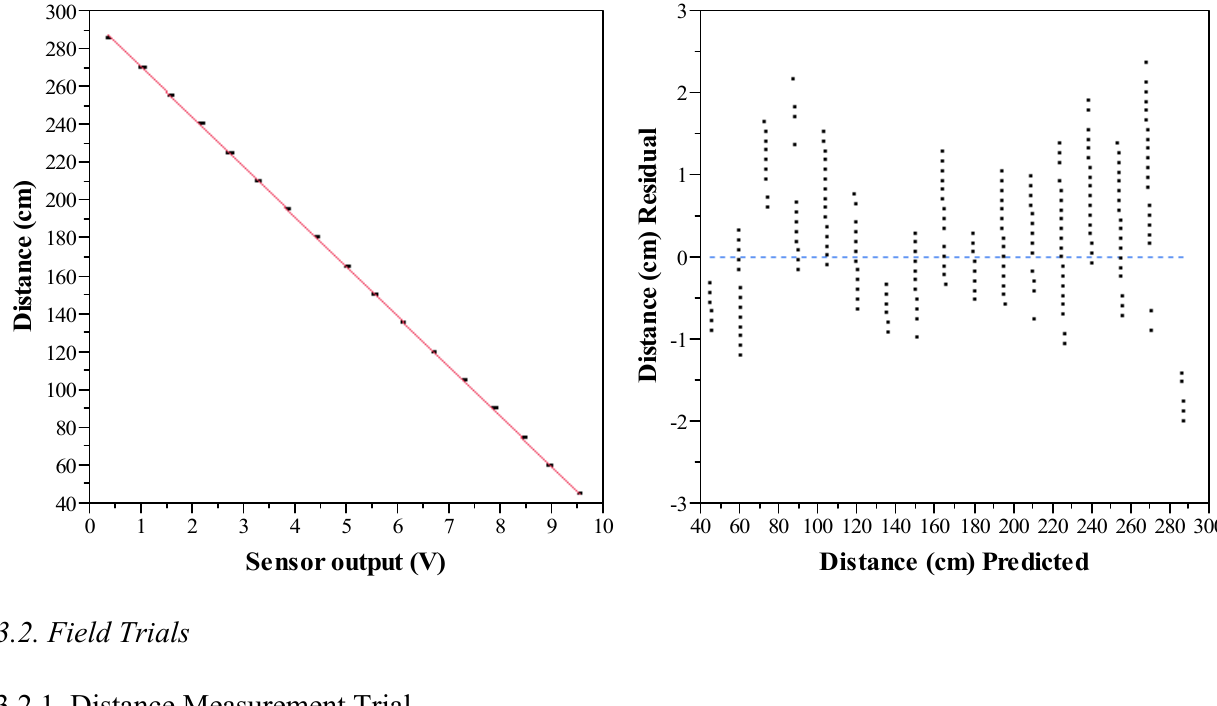
Figure 7. Scatter diagram of sensor output and distances ( left ) and residuals of predicted distances ( right ) for the laboratory distance measurement trial between 45 cm and 285 cm in steps of 15 cm. The red line in the diagram is the fitted regression